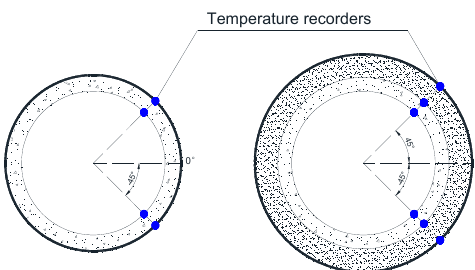
Figure 8. Layout of the temperature recorder.